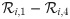
Entropy (i) and Jaccard index (ii) value distributions for the redescription sets created on each dataset (first dataset—D1 at the top, third dataset—D3 at the bottom).For a dataset Di, i ∈ {1, 2,3}, we create four redescription sets Ri,1-Ri,4 so that the number of described subjects in each redescription (from a particular redescription set) falls in the corresponding interval shown on the y-axis (boxplots representing distributions for each interval are coloured in different color). Each redescription set Ri,j,i∈{1,2,3},j∈{1,⋯,4} contains 100 redescriptions.